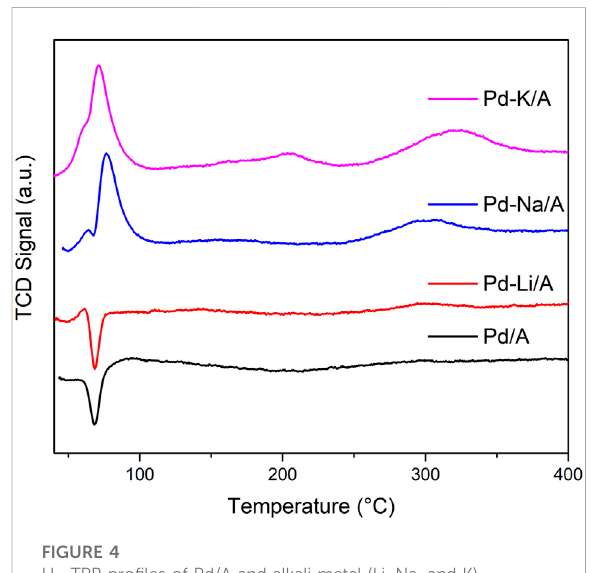
FIGURE 4 H 2 -TPR pro fi les of Pd/A and alkali metal (Li, Na, and K)- modi fi ed catalysts.